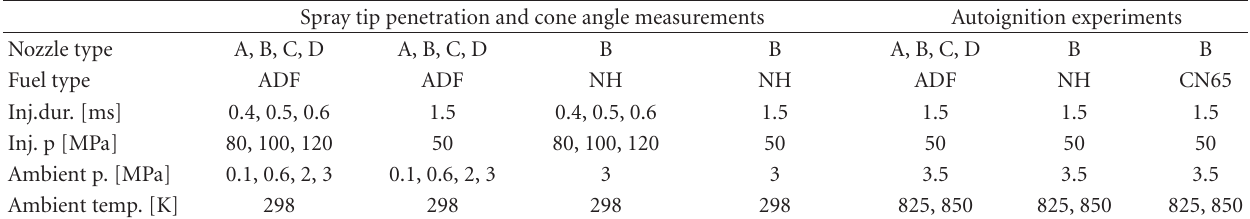
Table 3: Experimental conditions.